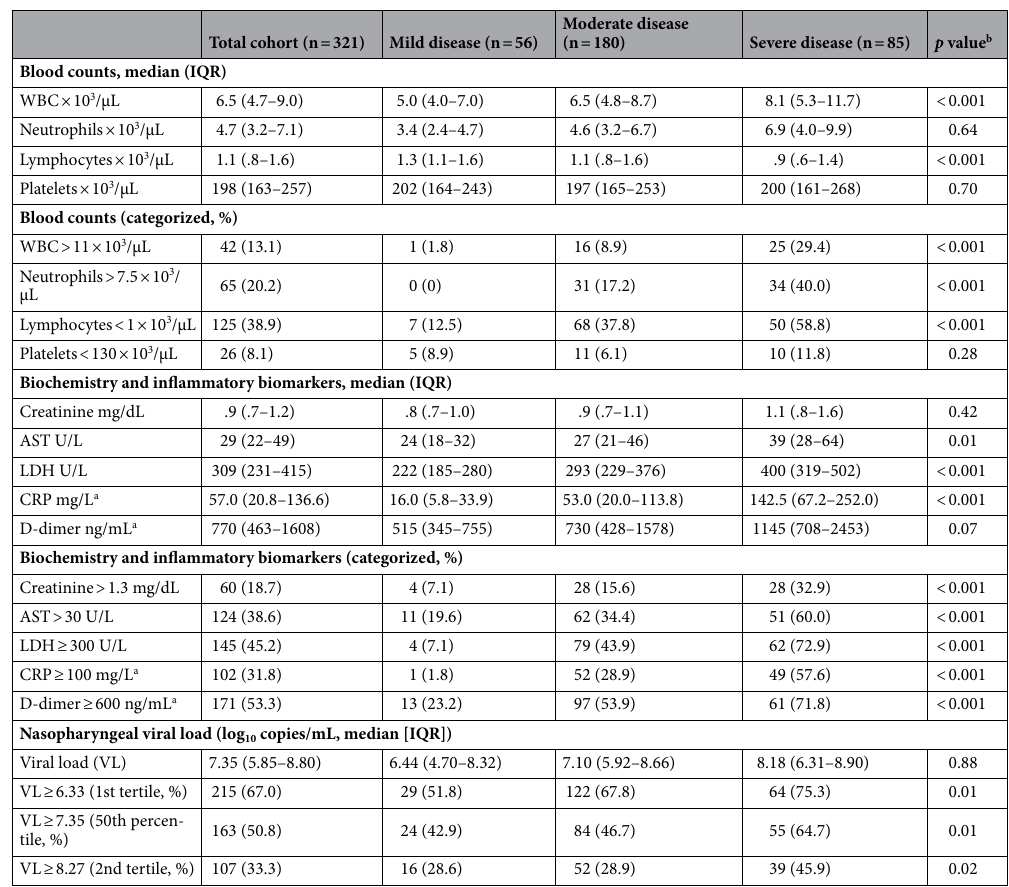
Table 2. Laboratory values and nasopharyngeal SARS-CoV-2 viral load of 321 patients with COVID-19 stratified according to disease severity. a Values were available in 293 and 276 patients for CRP and D-dimer, respectively. b Across all three